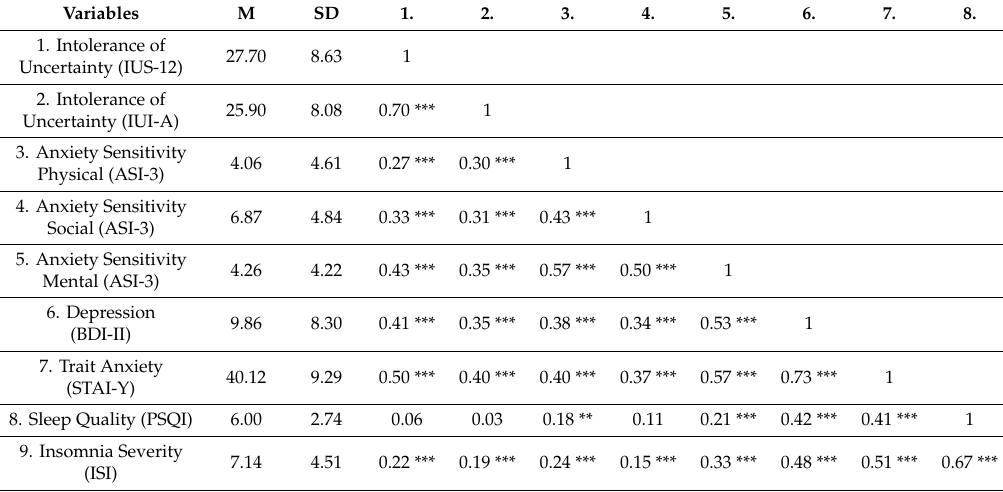
Table 1. Descriptive Statistics and relationships between